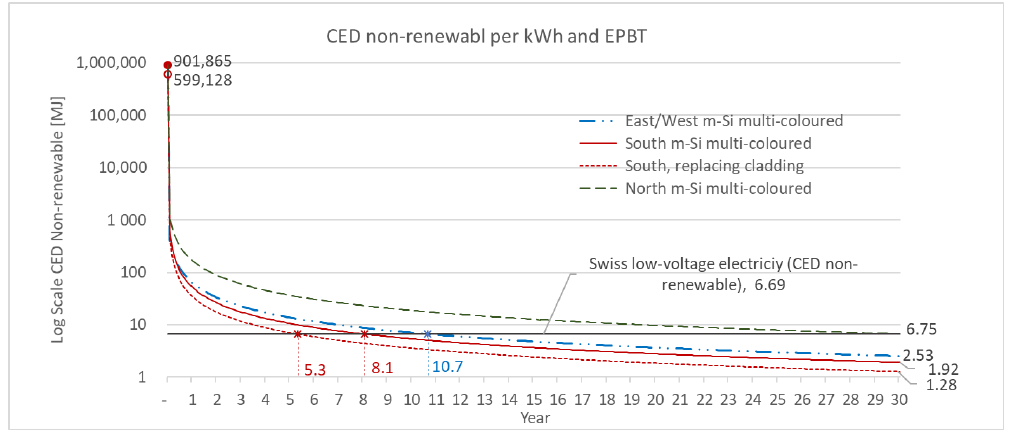
Figure 10. Cumulative energy demand (CED) non-renewable of an MCCG, m-Si PV façade over time, and energy pay-back time (EPBT) compared to Swiss low voltage electricity grid as